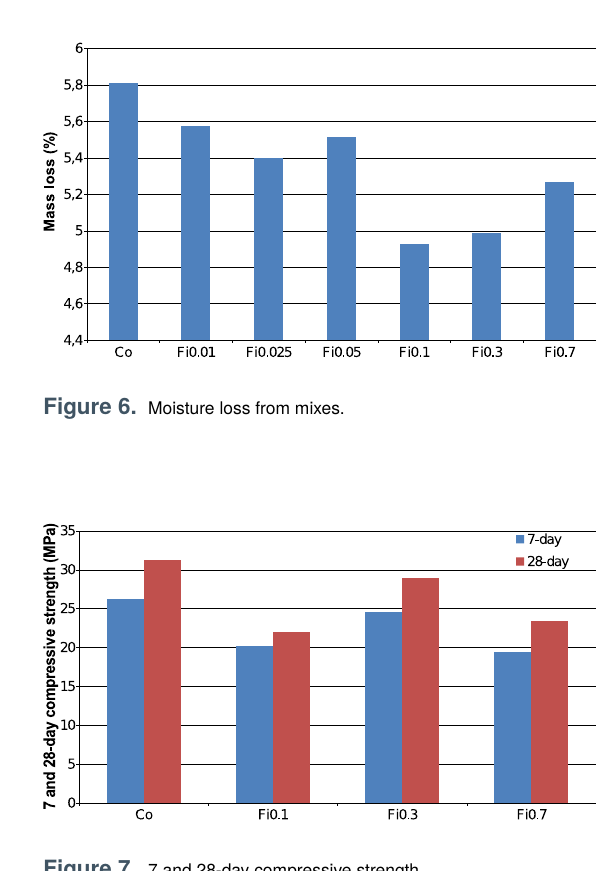
Figure 7. 7 and 28-day compressive